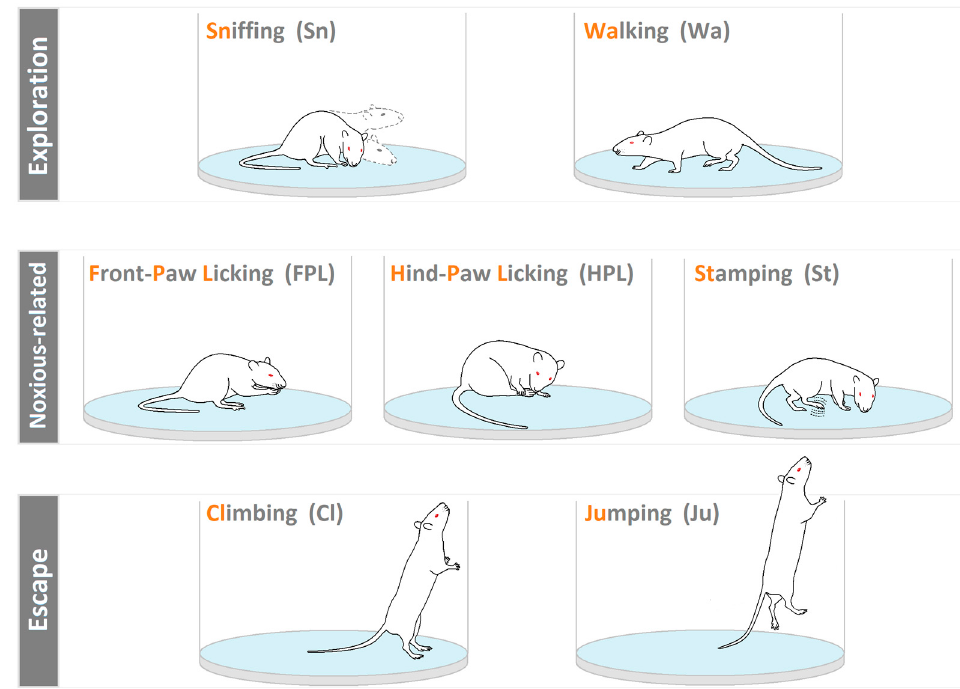
Figure 1. Ethogram of rat behavior. Exploration components = sniffing (Sn): The rat smells the environment, moving the vibrissae and/or the head; and walking (Wa): The rat walks around sniffing the ground and/or the Plexiglas cylinder. Noxious-related components = front paw licking (FPL): The rat licks its forepaws; hind paw licking (HPL): The rat turns its head toward its back paws and licks one of them; and shaking/stamping (St): A paw is rapidly shaken and/or stamped on the ground. Escape components = climbing (Cl): The rat leans against the Plexiglas cylinder; and jumping (Ju): The rat leaps off the surface, trying to pass over the Plexiglas cylinder.